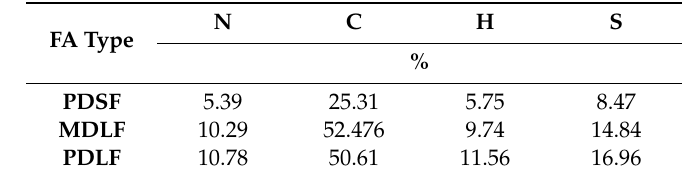
Table 3. Elemental composition of plant-derived liquid, mineral-derived liquid, and plant-derived solid fulvic